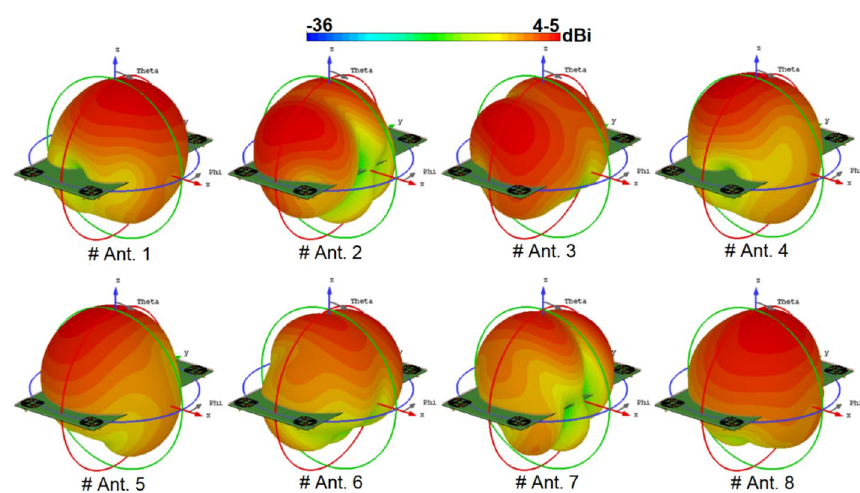
Figure 23. Typical radiation patterns for the modified GND MIMO antenna at 3.6 GHz.